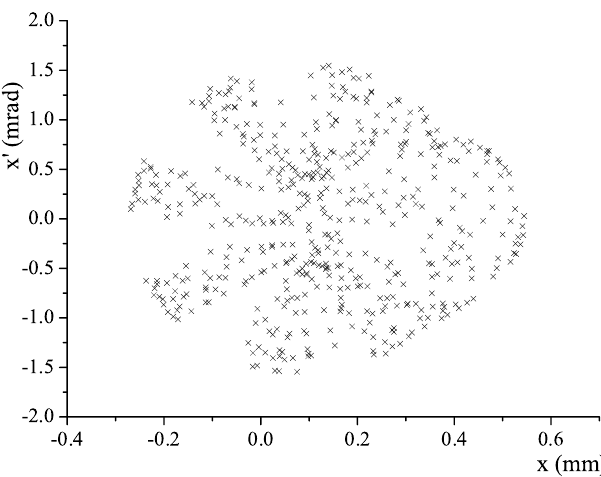
FIG. 5. Horizontal phase trajectory of a particle with large momentum deviation at IP azimuth in operation mode with large momentum compaction factor (cid:12) coordinates are x